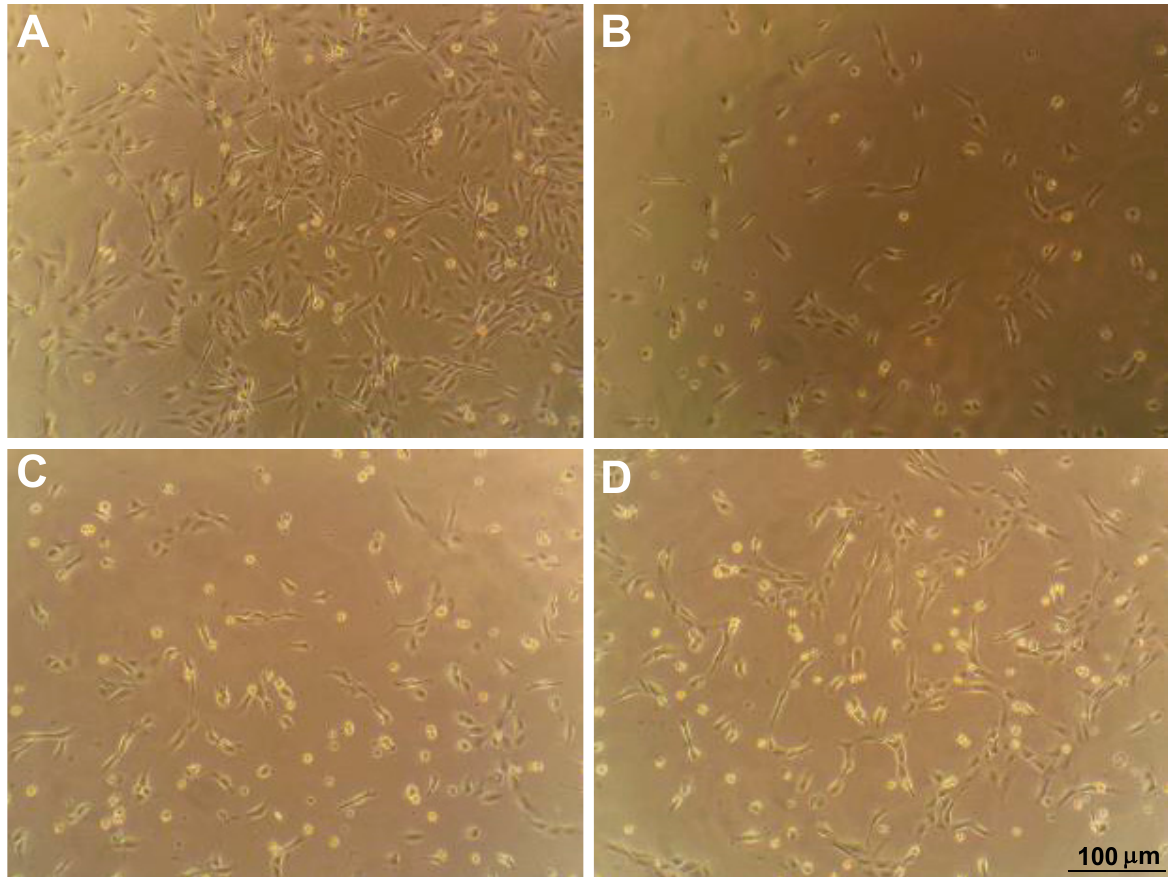
Figure 1. Mimetic peptides promote adherence of ARPE-19 cells. Phase-contrast microscopy of preparations of ARPE-19 cells maintained in vitro as described after plating on intact human type 1 atelocollagen ( A ) vs. collagen partially digested with activated MMP-1 ( B ). Treatment of cells plated on MMP-1 digested collagen with CMP 05A ( C ) and CMP 13A ( D ), both at a concentration of 100 µM. CMP 13A appears to improve adherence. Scale for each panel as indicated ( D ).